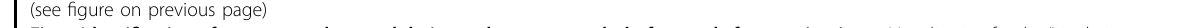
Fig. 5 Identi fi cation of master regulons and their regulatory networks before and after vaccination. a Visualization for the “ similarity-structure- associating ” metacells on the original scRNA-seq data. Metacells were color-coded according to their cell-type annotations. The original scRNA-seq data were color-coded “ blue ” and “ orange ” to represent samples “ before ” and “ after ” vaccination, respectively. b Top panels: rank of regulons in samples before (left) and after (right) vaccination, based on Regulon Speci fi city Score (RSS). Bottom panels: heatmap of top-ranked regulon activities before (blue) and after (orange) vaccination based on AUCell scores. Names of the regulons are color (blue/orange) and number coded (1 – 8). c Network of regulons and their target genes. The table below indicated the proportion of genes within the regulons which were up- or downregulated after vaccination. d Gene functional annotation and related genes before (blue) and after (orange) vaccination. e Schematic overview of the experiment. f After treatment with IFN- α / β , PBMCs from volunteers after vaccination had reduced expression of genes associated with type I interferon responses as compared to those before vaccination. Paired Wilcoxon test was used. * P ≤ 0.05, n =